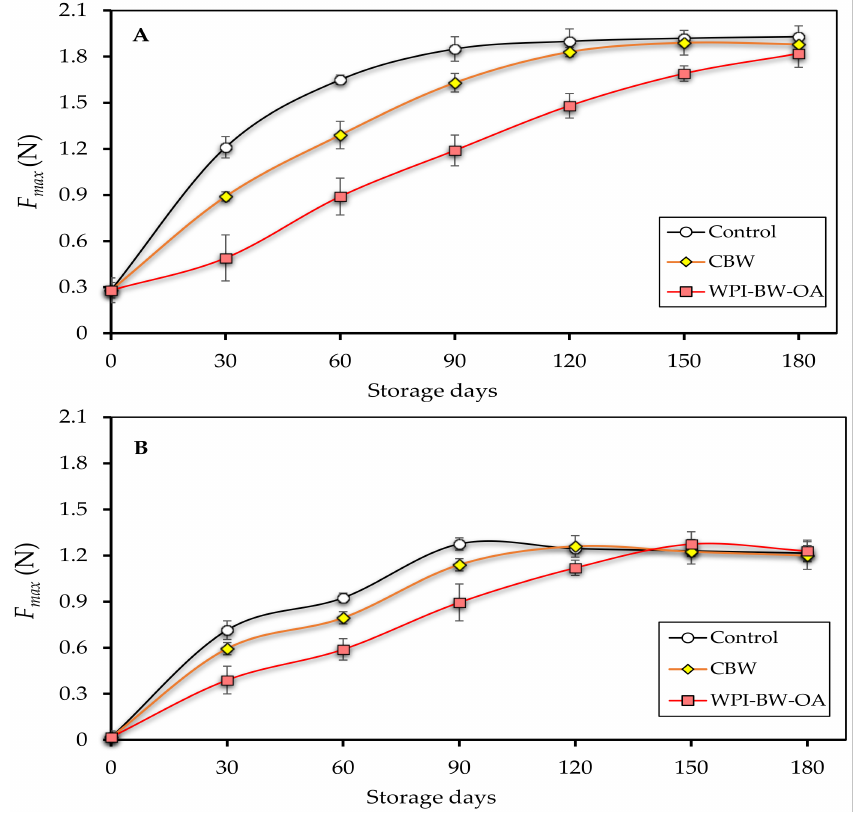
Figure 5. Effect of different composite coatings and storage time on firmness ( F max ) of uncoated and coated semi-moist apricot cubes mixed with cornflakes in apricot-cereals system: ( A ) semi-moist apricot cubes; and ( B ) cornflakes. Data are mean of triplicate measurements. Error bars indicate SD values. CBW, chitosan bees wax coating; WPI-BW-OA, whey protein isolate-bees wax-oleic acid